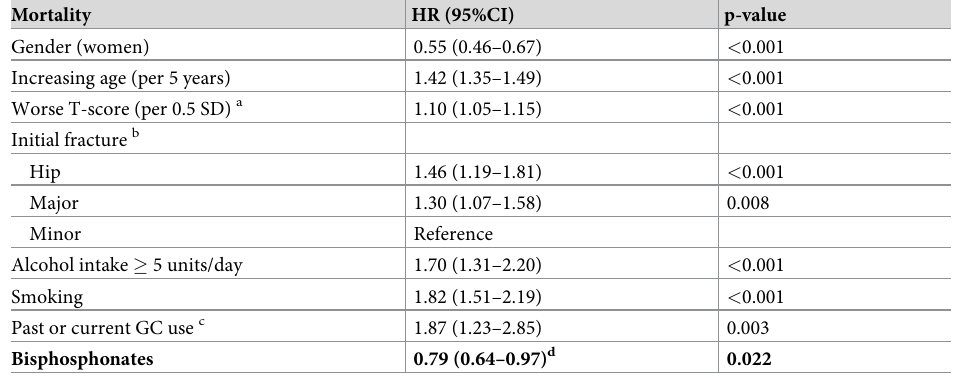
Table 3. Predictors of mortality. Multivariable Cox regression model; values are presented as hazard ratio’s (HR) with 95% confidence intervals (95%CI). Mortality HR (95%CI) p-value